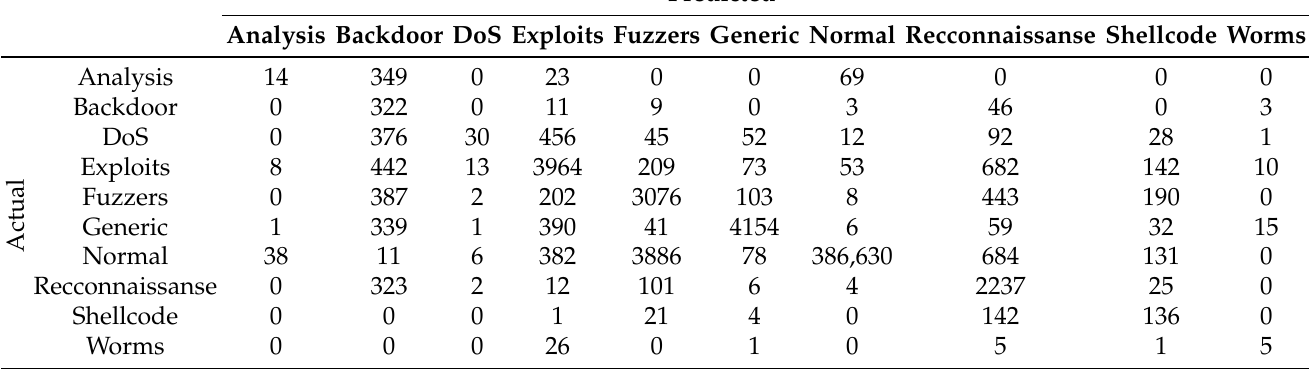
Table 19. Confusion matrix for UNSW-NB15 “class weights” multiclass classification experiment.